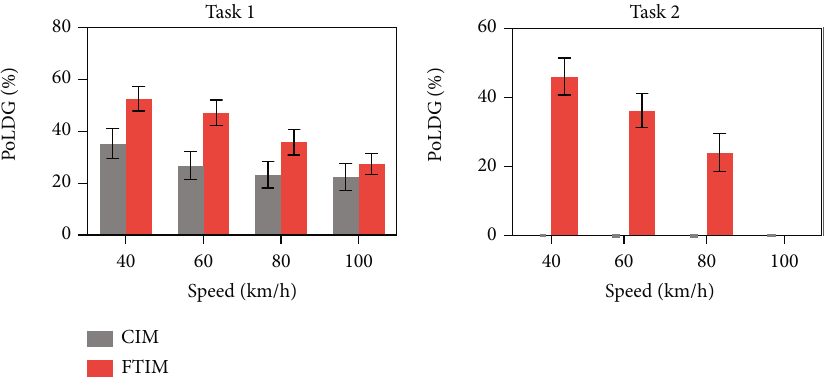
Figure 11: Percentage of glances to HMI longer than 2.0 s in